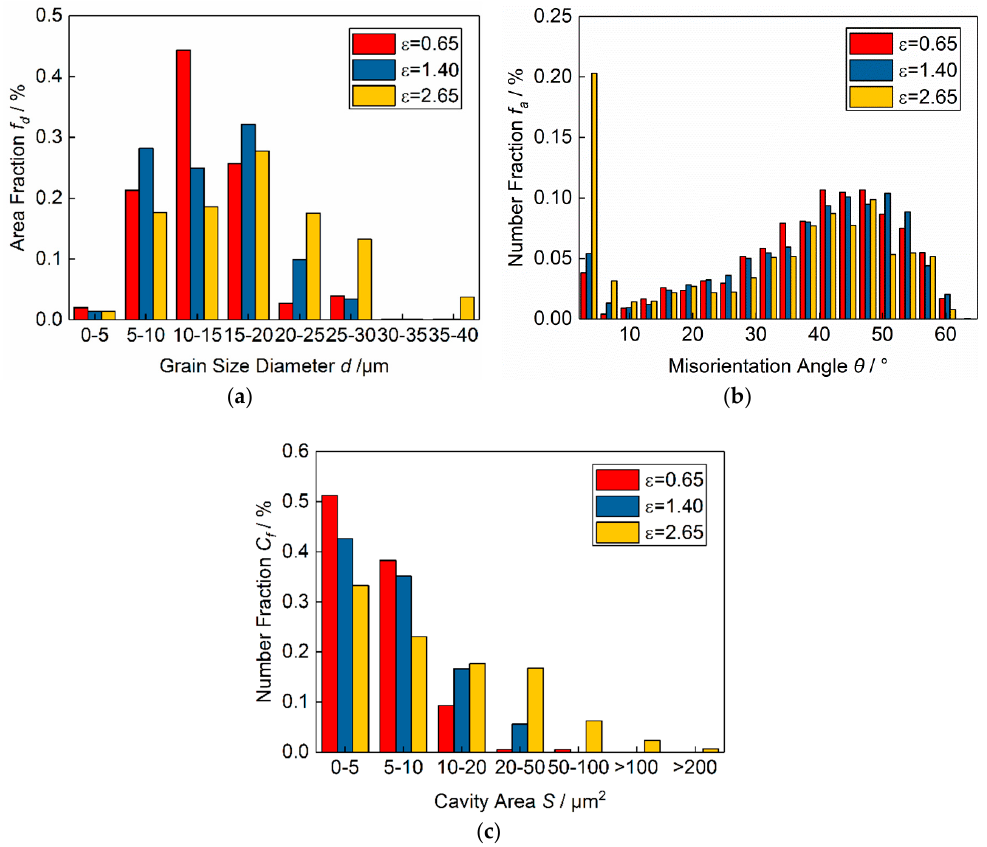
Figure 7. Distribution of the strain due to grain boundary sliding in ( a ) the dynamic recrystallization grain size, ( b ) the grain boundary angle rotation and ( c ) the number of cavity fraction in different strain stages. The superplastic tensile condition was 500 °C and 1 × 10 − 3 s − 1 of fine-grained 5A70 alloy.